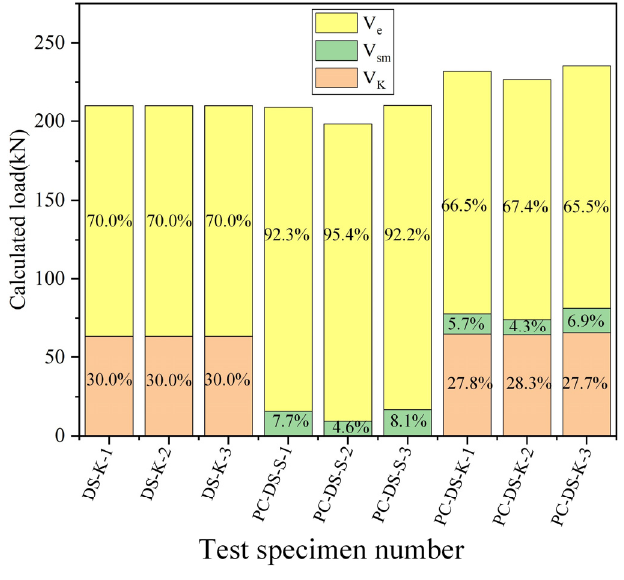
Figure 12. Contributions of each part of the interface.